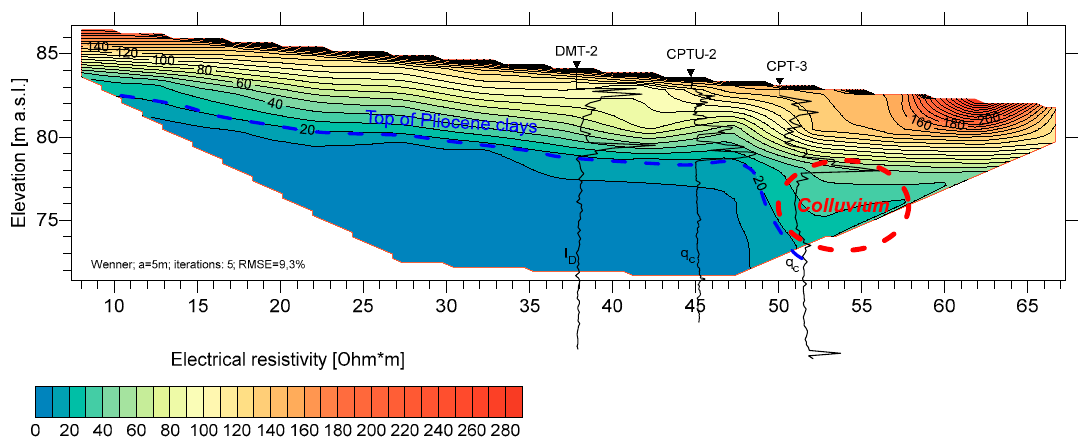
Figure 16. Geoelectrical cross-section in the Vistula slope area compared with cone resistance q c from CPTU and material index from DMT tests.